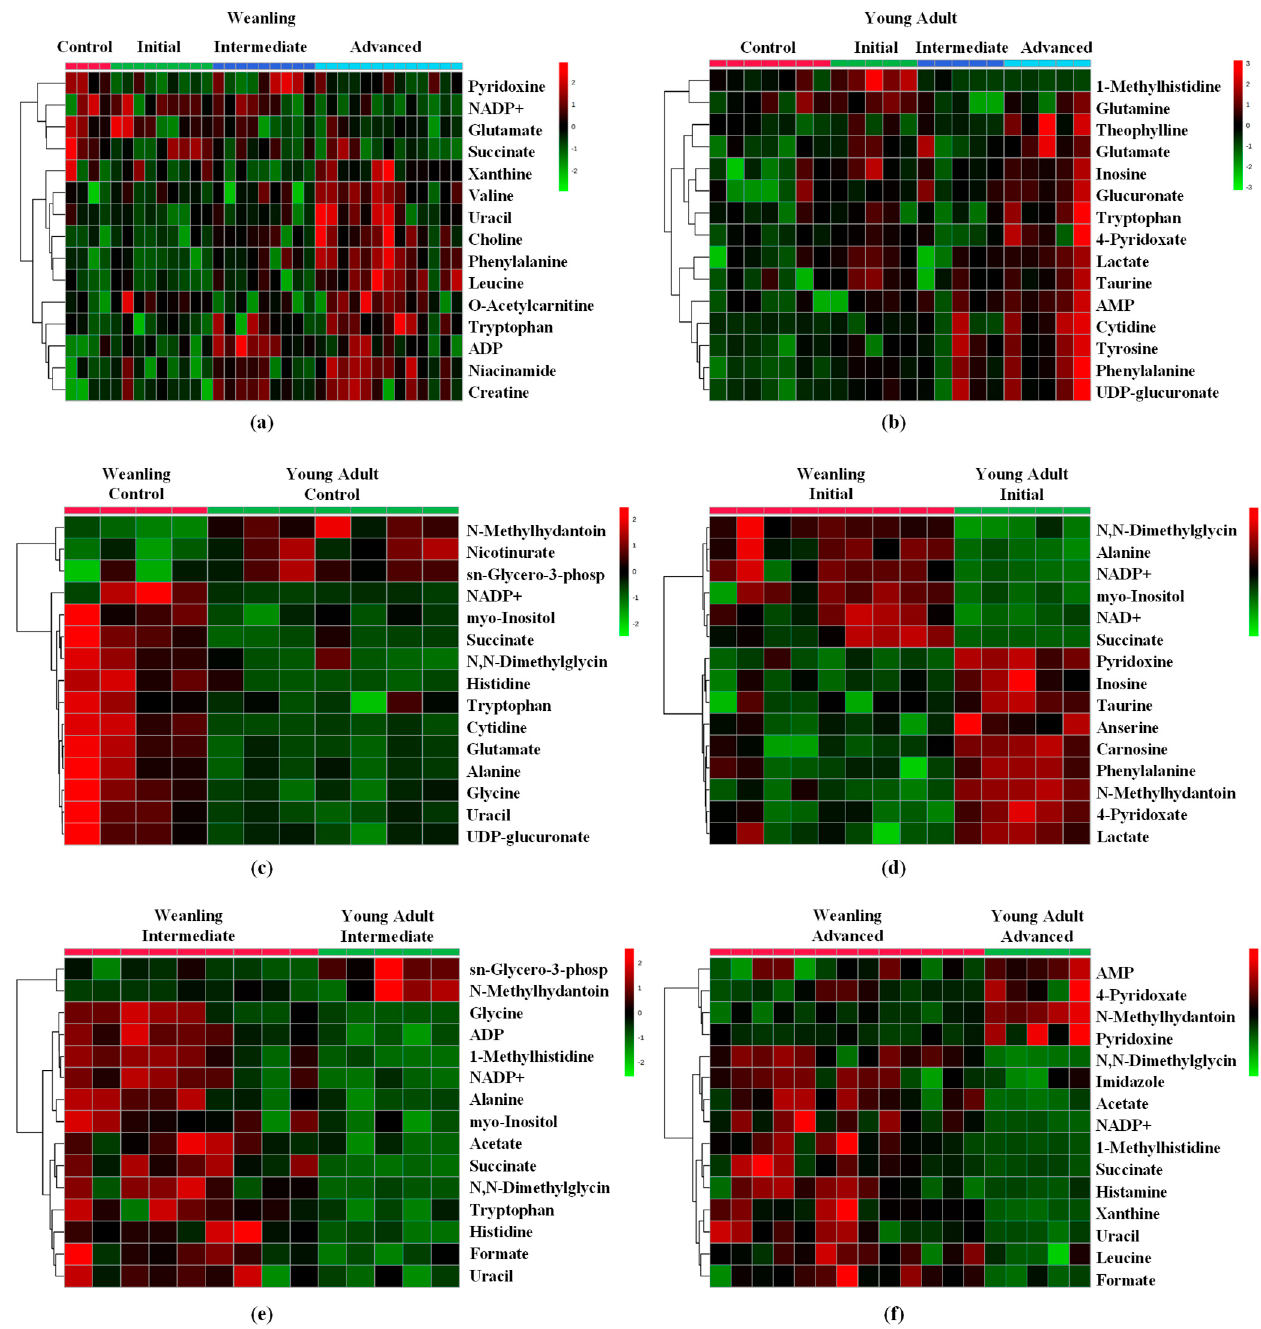
Figure 4. Heatmaps of gastrocnemius muscle identified in weanling and young adult female Walker-256 tumour-bearing rats. Concentrations of the 15 most important metabolites in ( a ) weanling and ( b ) young adult rats throughout tumour evolution (control—WC and AC; initial—WWi and AWi; intermediate—WWm and AWm; advanced—WWa and AWa) and regarding animal age (weanling and young adult) in ( c ) WC and AC, ( d ) WWi and AWi, ( e ) WWm and AWm, and ( f ) WWa and AWa Walker tumour-bearing rats. Legend: Data are expressed as abundance ratios (high: red and low: green) of the corresponding metabolites.